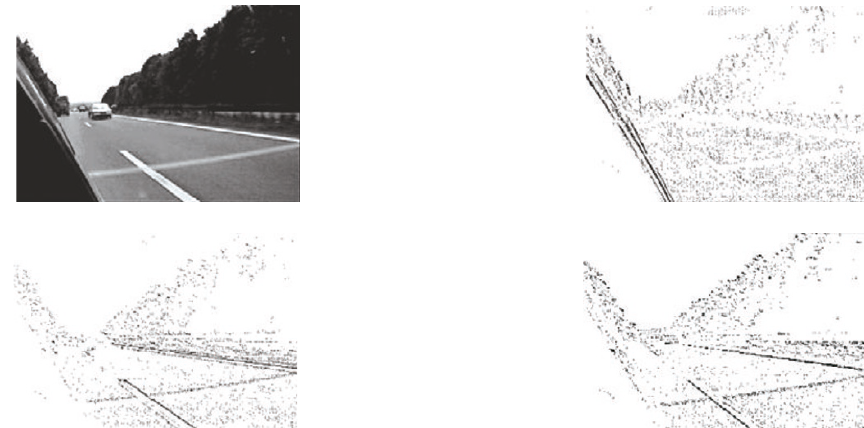
Figure 3: Sample image from car overtake monitoring system with (clockwise, from top left) original image and results for feature numbers 14,10, and 5,